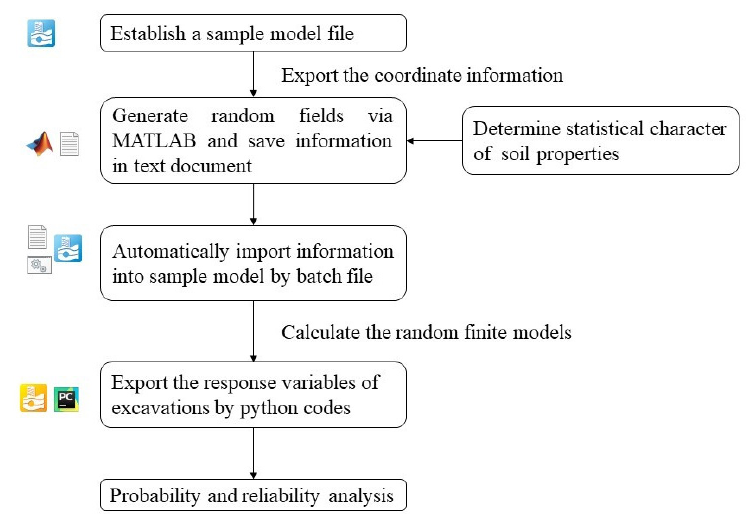
Figure 3. Flow chart of random finite element method.